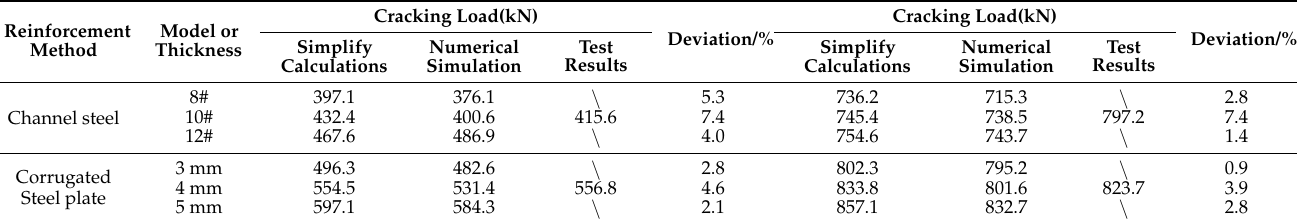
Table 4. Comparison of calculation results.